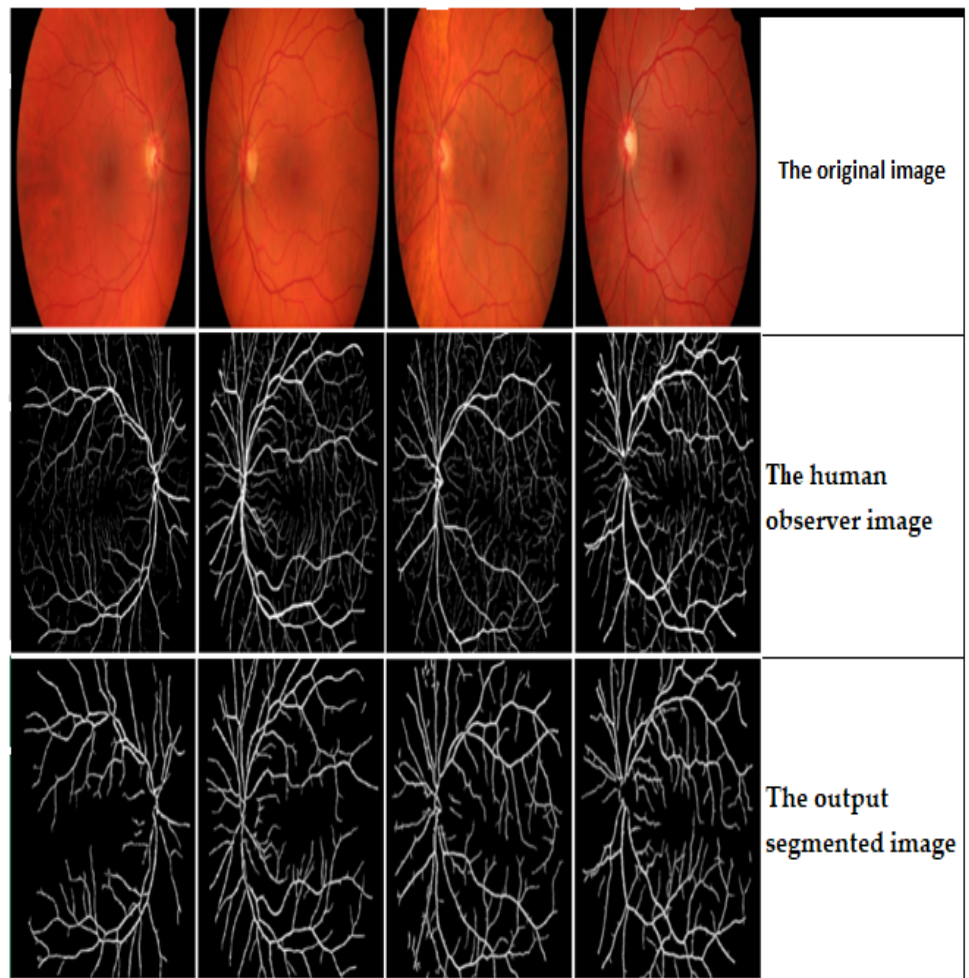
Figure 13. The output segmentation results of the proposed trainable filtering algorithm on the HRF dataset.